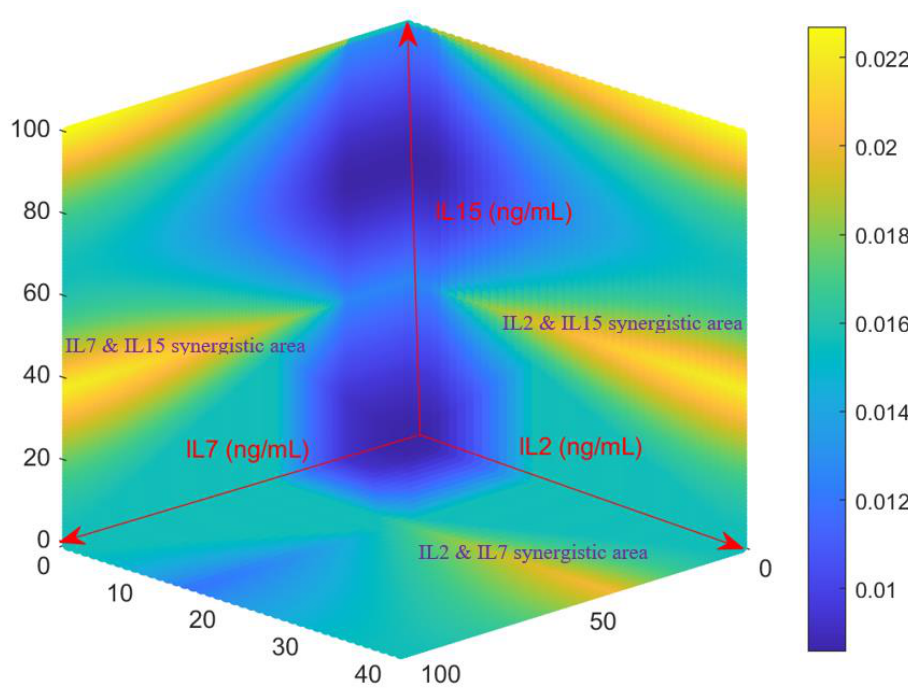
Figure 3. The growth rates of activated CD4 + T-cells (hr −1 ) predicted by the model for different combinations of cytokines. The model was assessed over the entire concentration space investigated by the growth studies to generate this map, with all possible combinations of IL-2 ∈ [0–40 ng/mL], IL-7 ∈ [0–100 ng/mL], and IL-15 ∈ [0–100 ng/mL]. The growth rate scale in (hr −1 ) are shown on the right, with yellow representing fastest proliferation and dark blue the lowest.